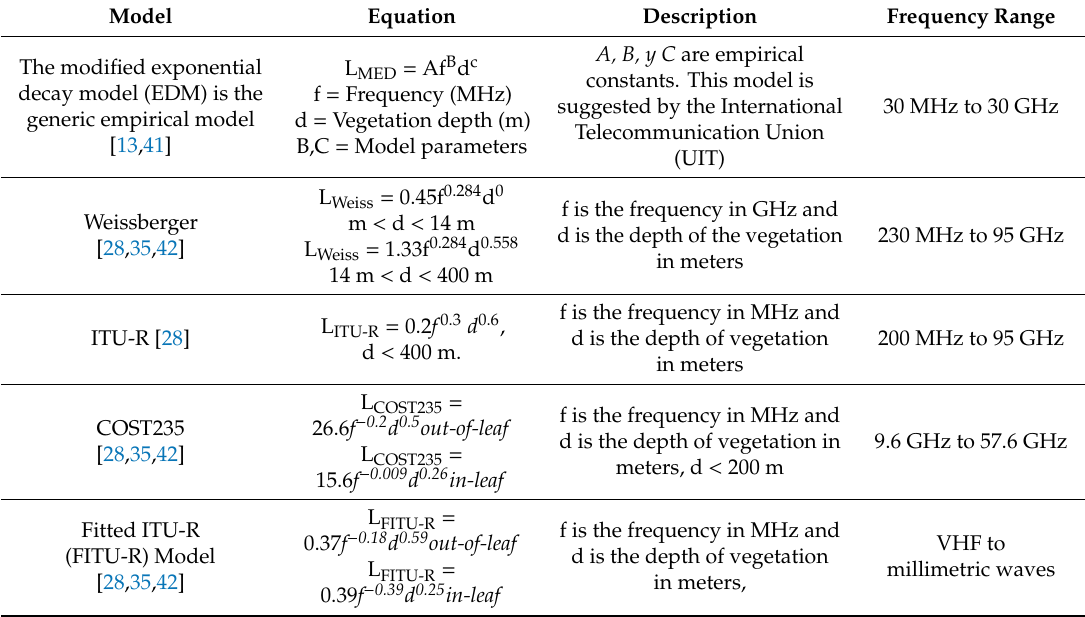
Table 1. Empirical propagation